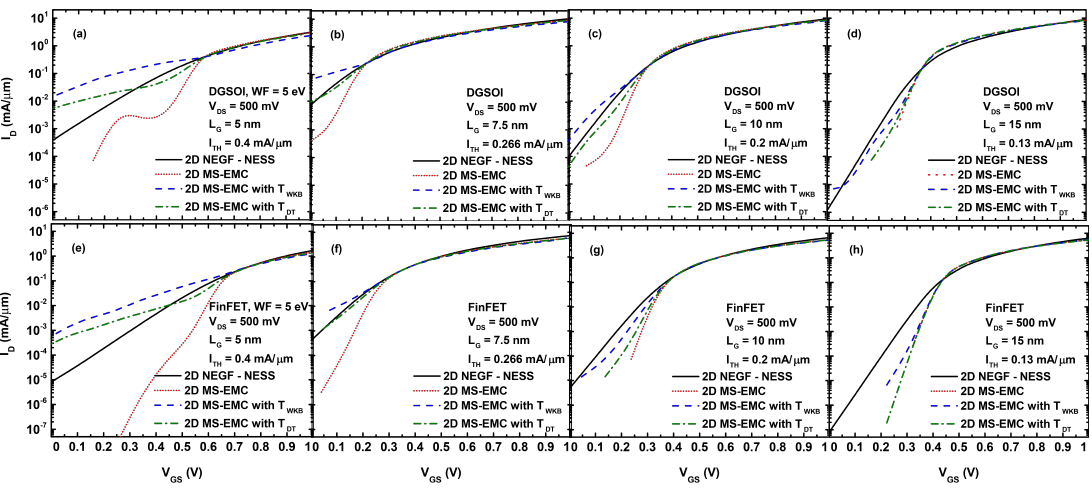
Figure 4. I D vs. V GS in the DGSOI and FinFET devices at V DS = 500 mV with L G 5 nm ( a , e ), 7.5 nm ( b , f ), 10 nm ( c , g ), and 15 nm ( d , h ), considering the four types of simulations are: (1) Non-Equilibrium Green’s Function (NEGF) approach in the Nano-Electronic Simulation Software (NESS) tool, (2) Multi-Subband Ensemble Monte Carlo (MS-EMC) tool without any type of tunneling, and MS-EMC tool with the Source-to-Drain tunneling (S/D tunneling) module using (3) T WKB (E x ) and (4) T DT (E x